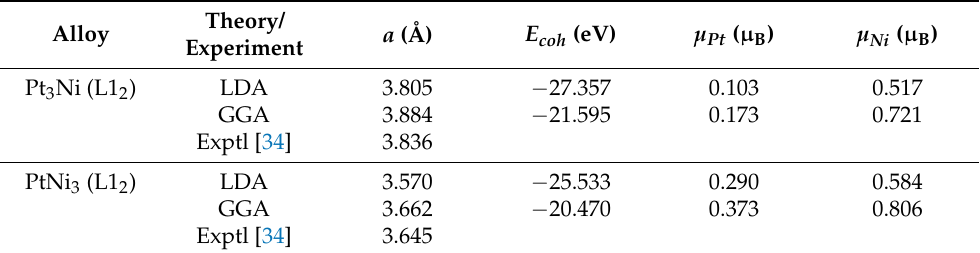
Table 3. The bulk lattice parameters a , cohesive energies E coh and magnetic moments µ Pt and µ Ni for the Pt 3 Ni and PtNi 3 . The ‘Theory/Experiment’ column shows the exchange-correlation functional used (LDA/GGA) in the case of theoretical estimates of each of the physical parameters or shows the experimental value (‘Exptl’) where available.